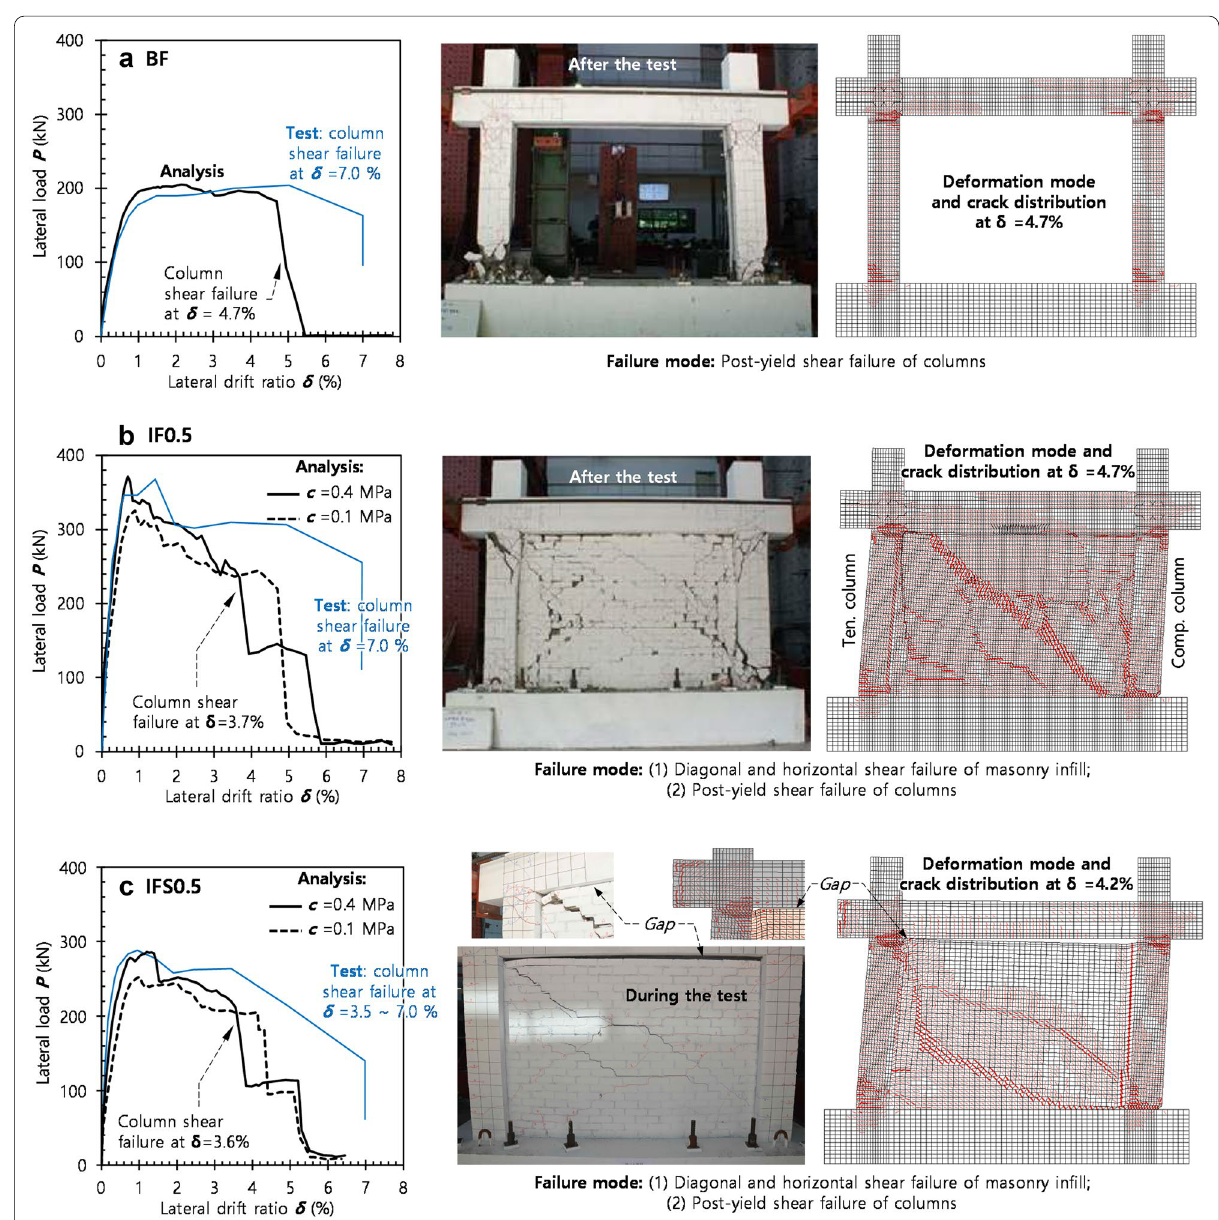
Fig. 5 Lateral load–drift ratio relationship and failure mode: test vs.